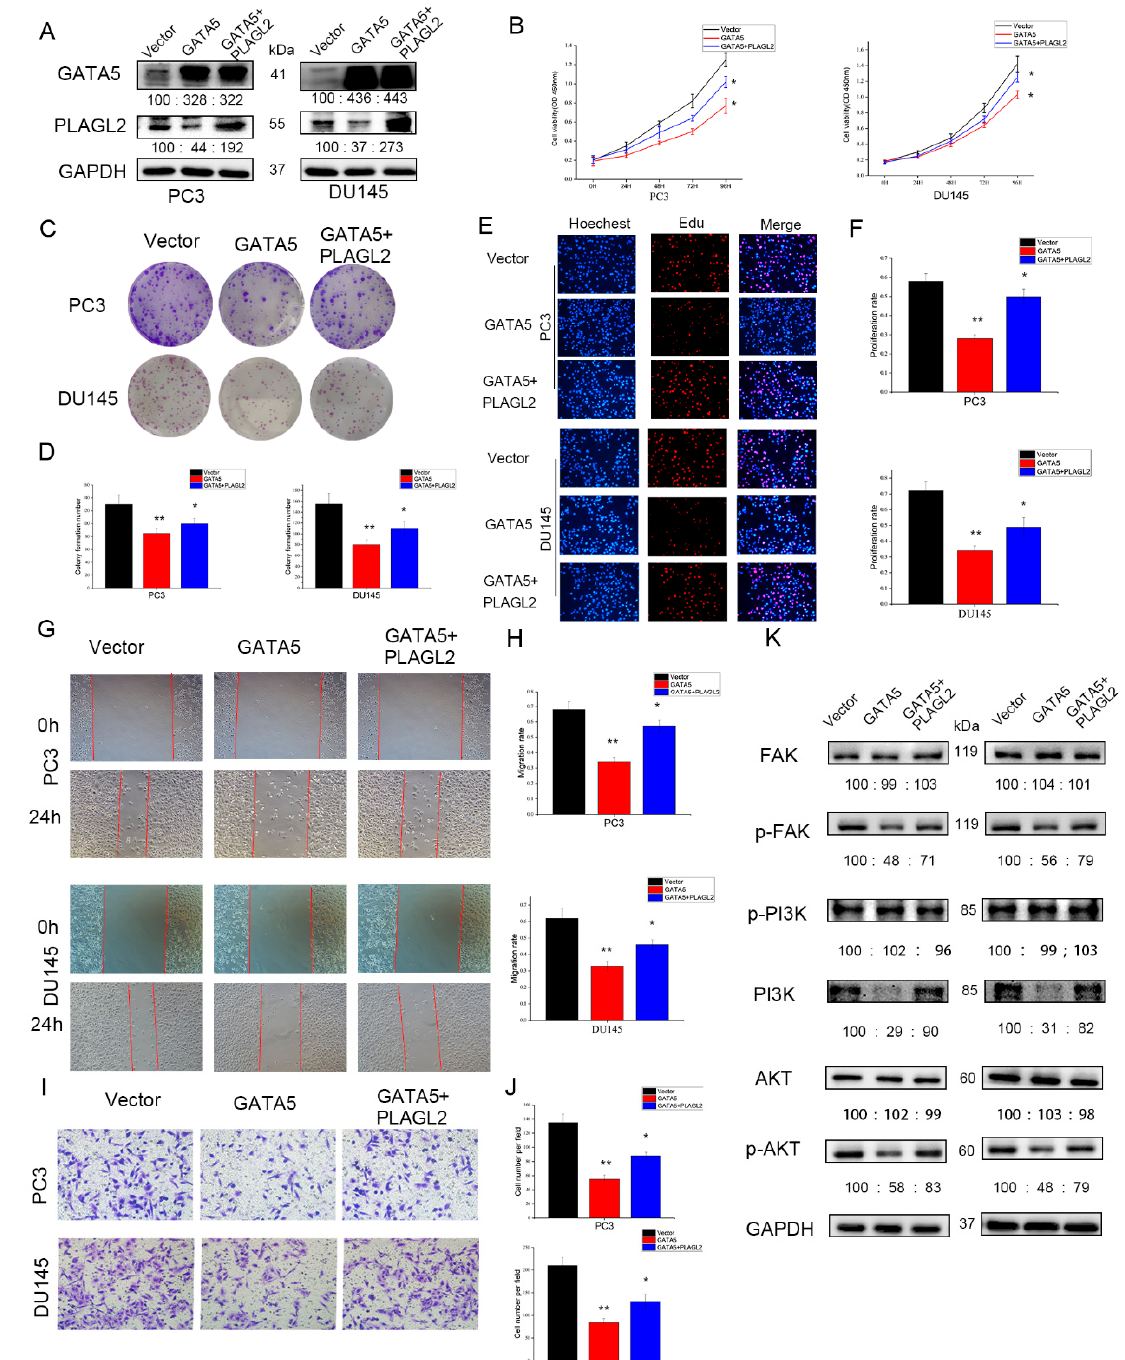
Figure 8. Overexpression of PLAGL2 reverses the effects of GATA5 in PCa cell lines. ( A ) The PLAGL2 overexpression cell line was constructed. ( B – F ) PLAGL2 overexpression could alleviate the inhibitory effect of GATA5 on cell proliferation. ( G – J ) The migration and invasion ability of cells were partially restored after overexpression of PLAGL2. ( K ) PLAGL2 overexpression had the opposite function on the FAK/PI3K/AKT pathway compared with GATA5. Data are presented as mean ± SD of at least three experiments. * p < 0.05 and ** p < 0.01.